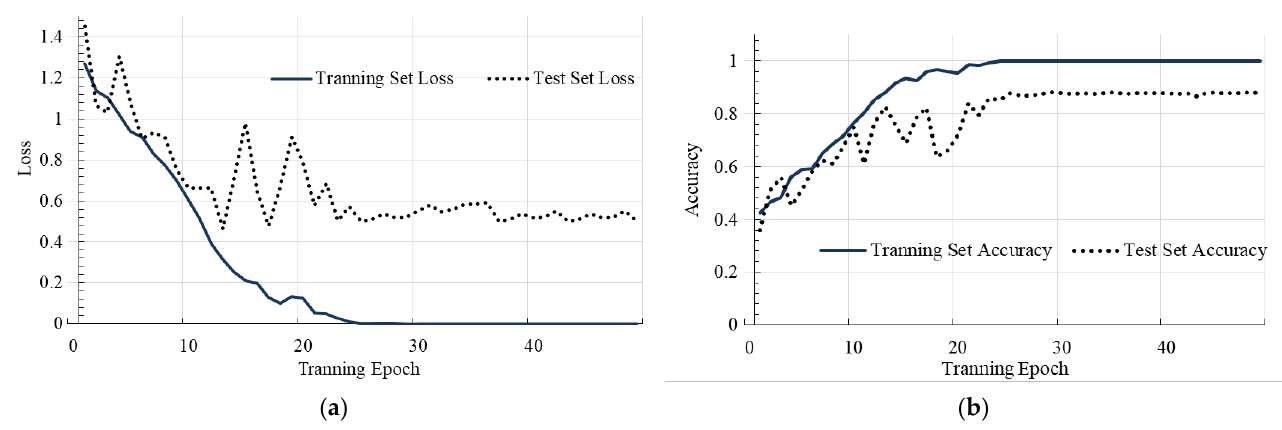
Figure 8. Loss plot and accuracy plot of training and test sets of RAVDESS dataset for Stage 1 (Emotional Categorization) in Cascaded DL framework. ( a ) Loss vs. Training Epoch; ( b ) Accuracy vs. Training Epoch. Table 3. Test set confusion matrix on emotion category in Stage 1 of Cascaded DL